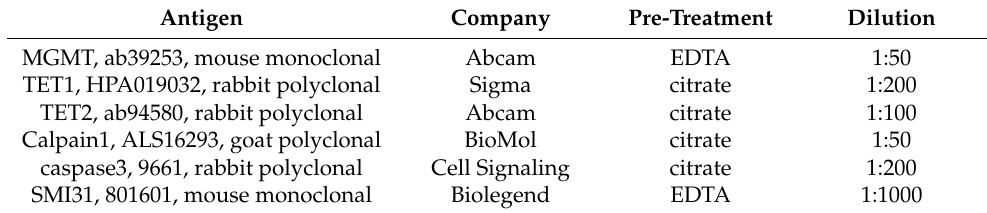
Table 2. Antibodies and staining